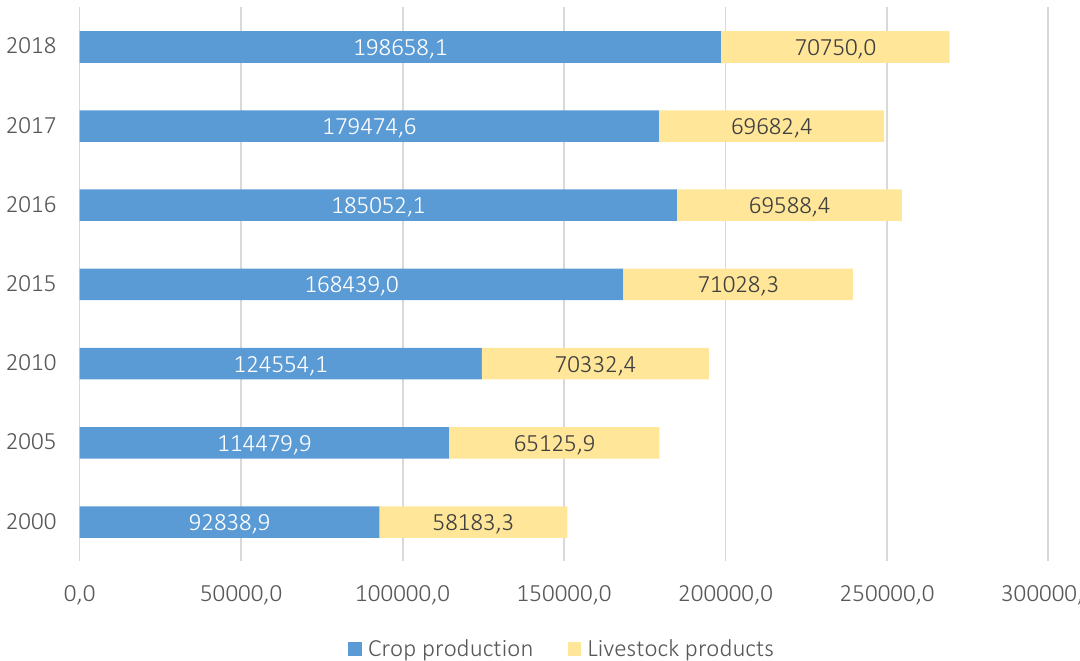
Figure 4. Dynamics of agricultural production in Ukraine, at constant prices in 2010, UAH